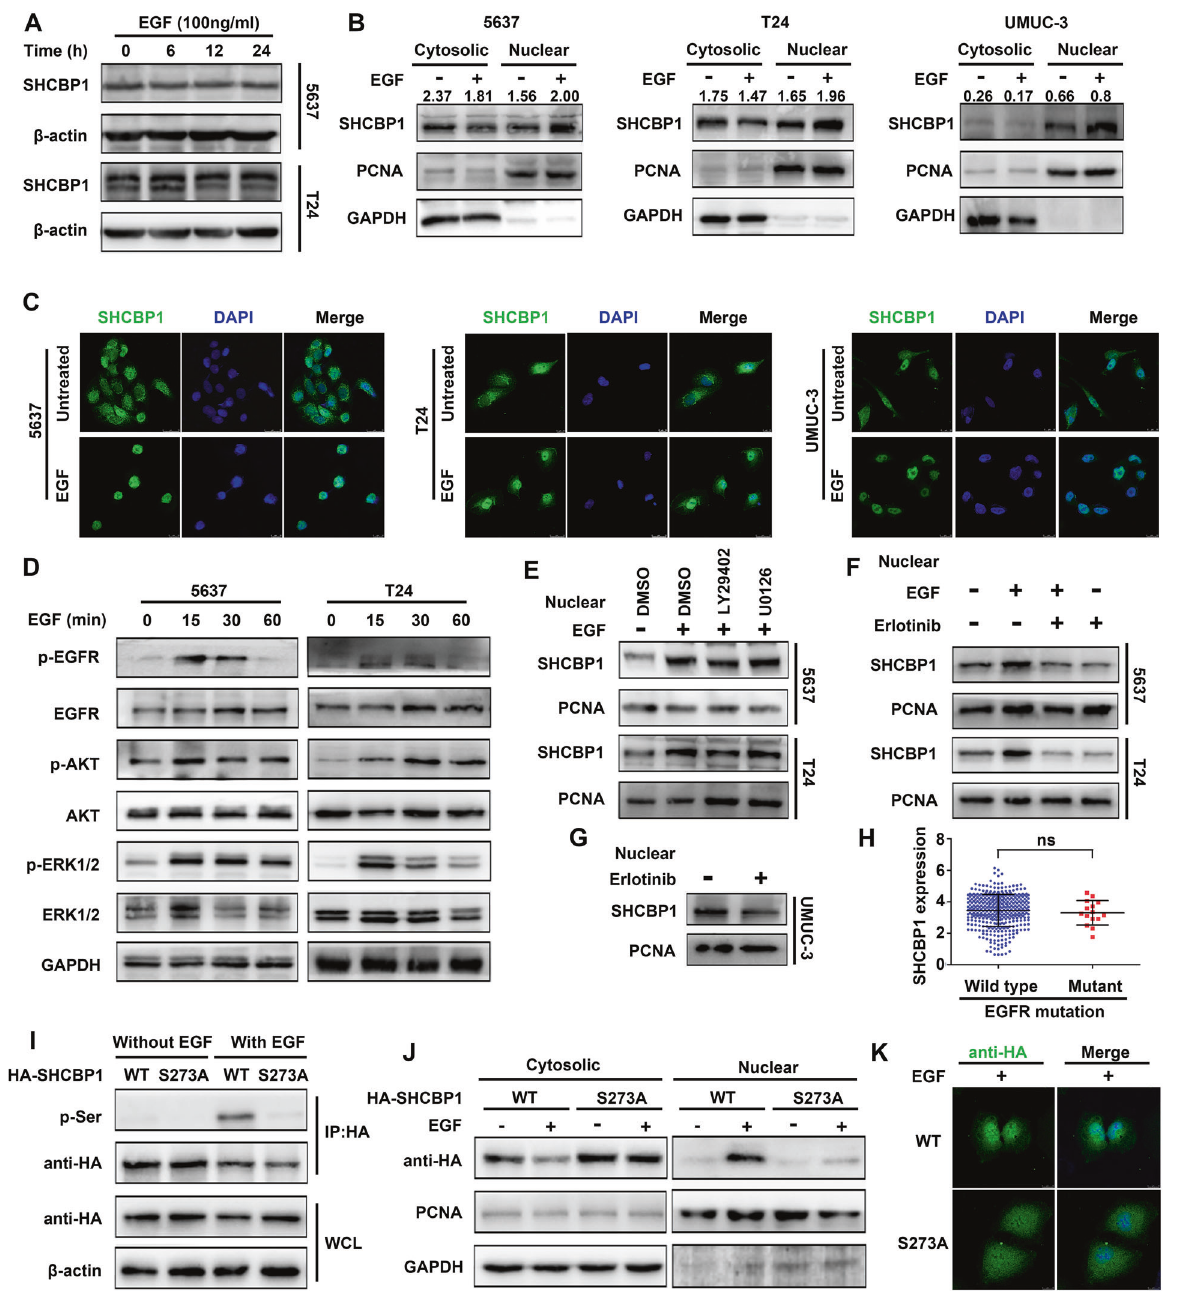
Fig. 2 EGF promotes SHCBP1 nuclear translocation. A Immunoblotting analysis showing total expression of SHCBP1 protein after EGF treatment (100 ng/ml) at the indicated time points in 5637 and T24 cells. B Immunoblotting analysis showing SHCBP1 redistribution in the cytoplasm and nucleus following EGF stimulation for 30 min in 5637, T24, and UMUC-3 cells. Quanti fi ed value of SHCBP1 compared to internal control was shown. C IF images indicating SHCBP1 localization from the cytoplasm to the nucleus after EGF treatment in 5637, T24, and UMUC-3 cells. D Immunoblotting analysis showing the expression of p-EGFR, p-AKT, and p-ERK1/2 in response to EGF at the indicated time points in 5637 and T24 cells. E Immunoblotting analysis determining the impact of a PI3K/Akt inhibitor (LY294002, 20 µM) or an ERK1/2 inhibitor (U0126, 10 µM) on the nuclear translocation of SHCBP1 in 5637 and T24 cells. F EGF-induced SHCBP1 nuclear translocation was examined after erlotinib (EGFR tyrosine kinase inhibitor) treatment in 5637 and T24 cells. G SHCBP1 nuclear translocation was examined by immunoblotting in the absence or presence of erlotinib in UMUC-3 cells. H SHCBP1 expression in bladder cancer patients with or without EGFR mutation was compared (data from TCGA). I Following immunoprecipitation against HA, SHCBP1 phosphorylation was detected using immunoblotting with an anti-phosphoserine (pSer) antibody in lysates from T24 cells transfected with HA-SHCBP1 (WT) or mutant HA-SHCBP1 (S273A) and treated with EGF. J , K Immunoblotting and IF showing the subcellular localization of HA-SHCBP1 or mutant HA-SHCBP1 (S273A) in T24 cells in response to EGF.